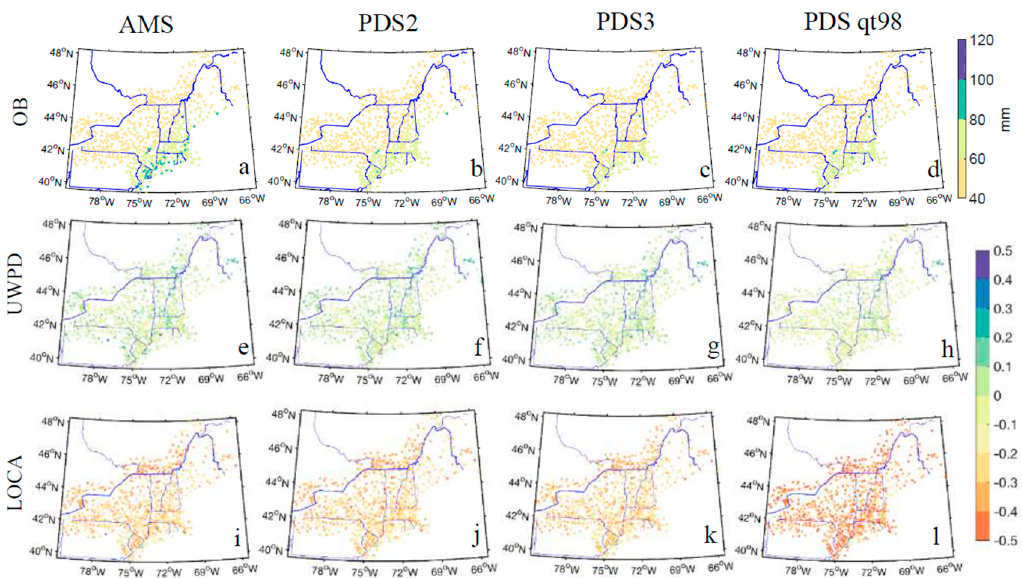
Figure 3. The 1960–2005 climatology of the AMS ( a ), PDS2 ( b ), PDS3 ( c ), and PDS qt98 ( d ), based on the observational data and the relative differences defined as (model – observation)/observation) for the UWPD ( e – h ) and LOCA ( i – l ) data.